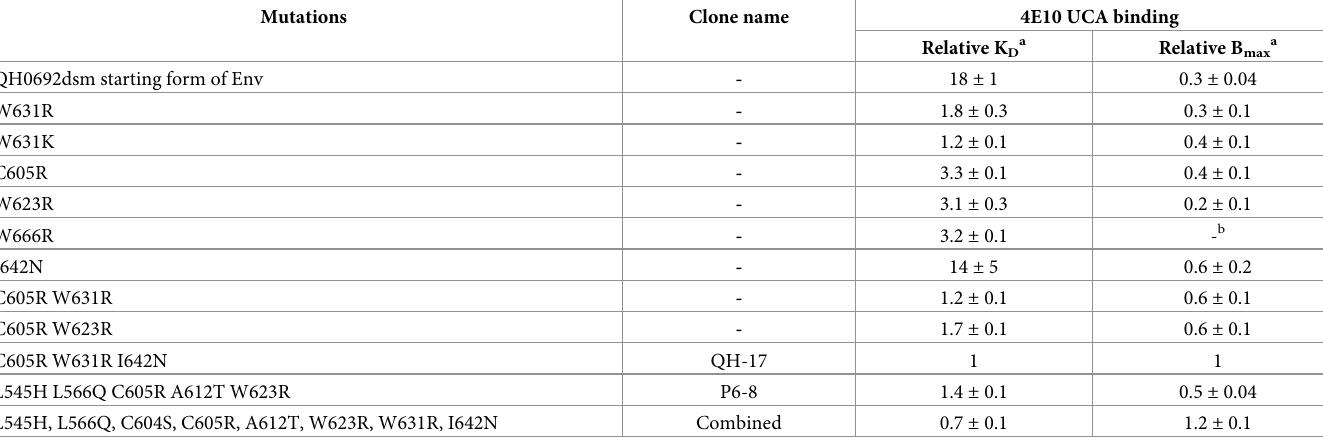
Table 3. Binding parameters for mutation combinations reconstructed in the QH0692 Env by site-directed mutagenesis.